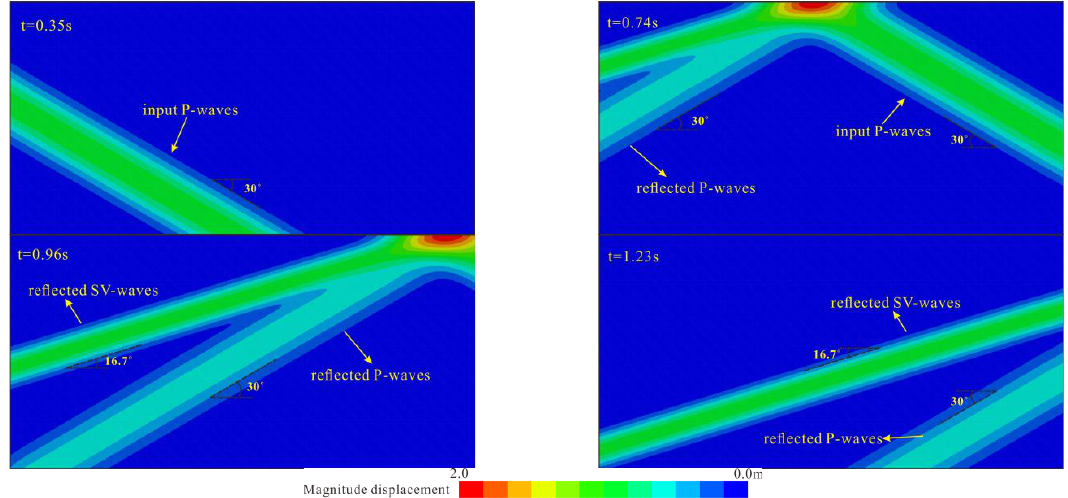
Figure 9. Displacement contours of P waves propagated in semi-infinite space.